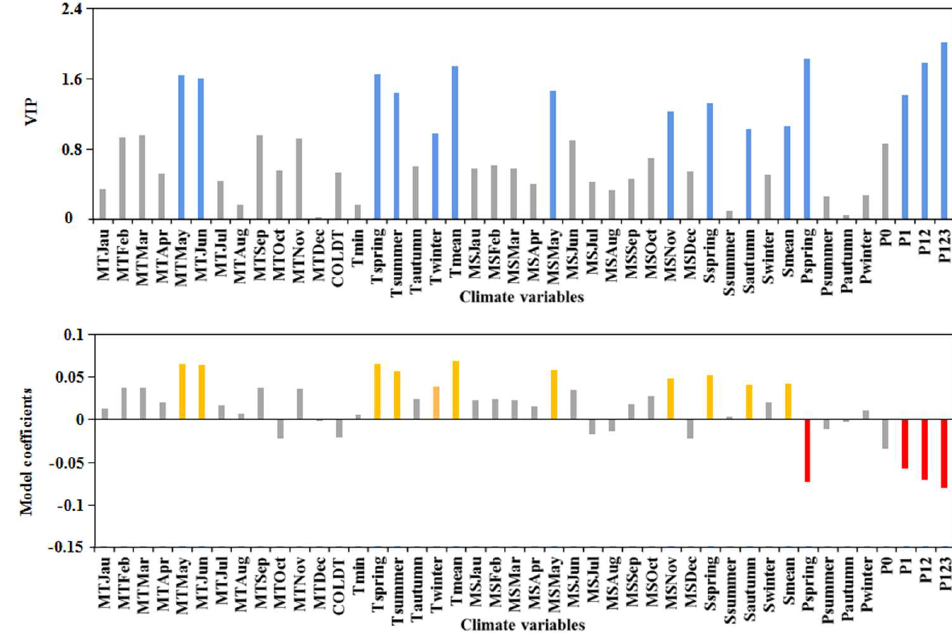
Figure 8. Results of the partial least squares regression analysis. Blue bars (figure above ) indicate that the variable importance projection (VIP) score exceeds the 1 threshold. Yellow bars (figure below ) indicate positive (and important) model coefficients, whereas red bars indicate negative (and important) model coefficients, and gray bars indicate unimportant model coefficients.